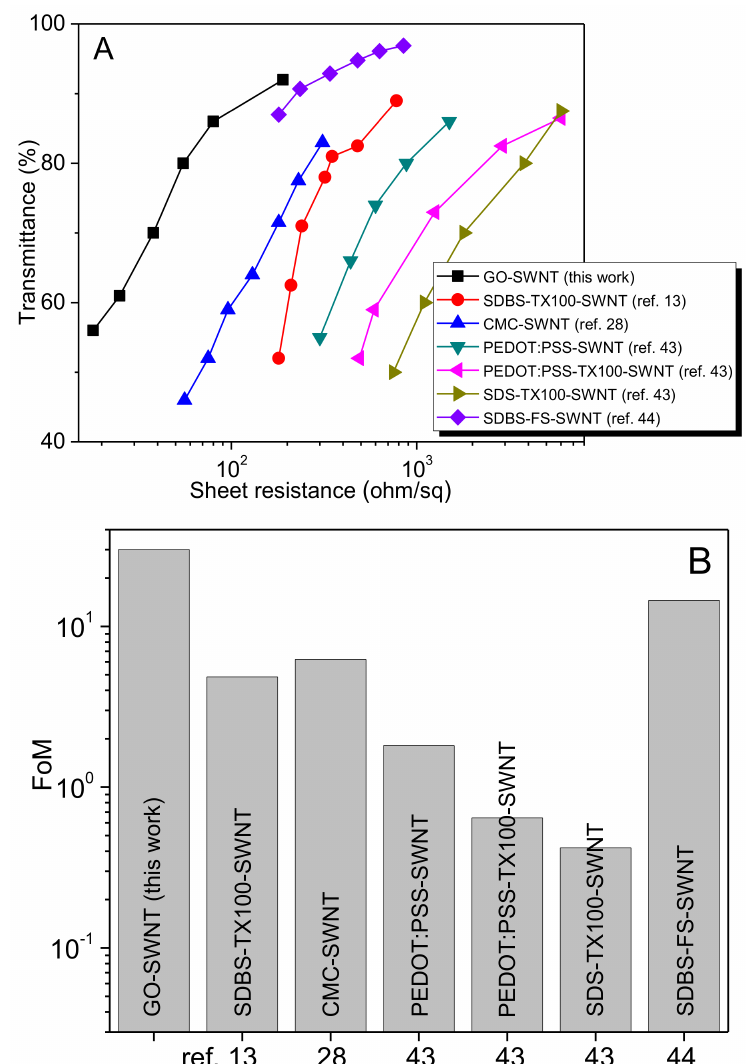
Figure 9. Comparison of electrical properties of rGO-SWNT film with those films contained other dispersing agents. ( A ) Transmittance versus sheet resistance profiles; ( B ) Comparison of figure of merit (FoM) CMC: sodium carboxymethyl cellulose; SDS: sodium dodecyl sulphate; FS: fluorosurfactant